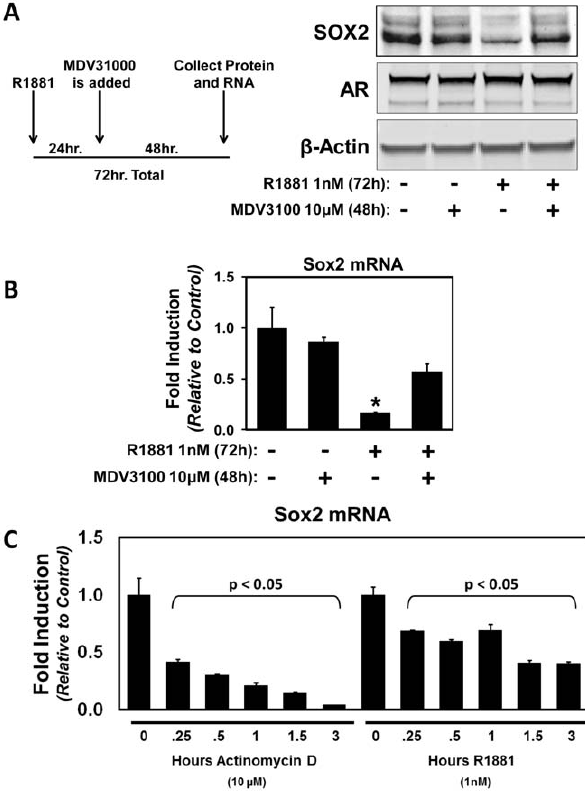
Figure 5. Androgen Receptor-mediated repression of Sox2 expression can be reversed by treatment with the Anti- Androgen MDV3100. A ) To verify that the decrease of Sox2 protein is specific to AR activation and can be reversed by an AR antagonist, CWR-R1 cells were grown in 1 nm R1881 or vehicle for 24 hrs, and then either 10 m M MDV3100 or vehicle was added to the culture medium for an additional 48 hrs. Western blots show a decrease in Sox2 protein with R1881 that can be returned to basal levels with addition of MDV3100, without any change in AR protein. b -Actin was used as a loading control. A schematic outlines the time frame of these experiments. B ) A decrease of Sox2 mRNA with R1881 treatment was measured using qPCR (*p , 0.05), which was brought back to control levels upon treatment with MDV3100. C ) A time course of treatment with a known inhibitor of transcription, 10 m M Actinomycin D, yielded a similar rapid decrease of Sox2 mRNA in CWR-R1 cells upon AR stimulation with R1881 as measured by qPCR. Levels at 0.25 hrs and beyond represent a statistically significant decrease in Sox2 mRNA (p , 0.05), showing similar kinetics of transcriptional repression with both R1881 and Actinomycin D drug treatments.